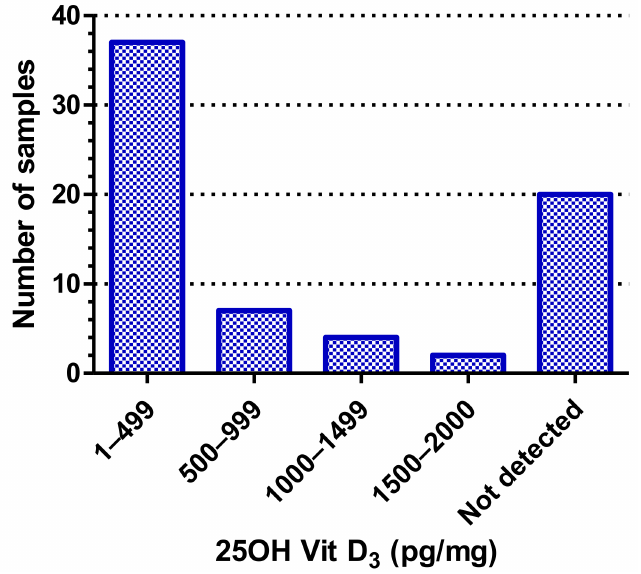
Figure 2. Prevalence and distribution of 25 hydroxyvitamin D 3 levels in the hair of young Emirati males.